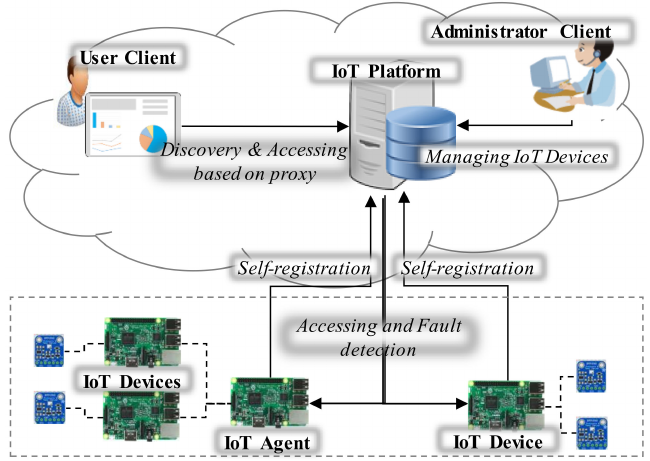
Figure 1. Internet of Things (IoT) architecture for proposed resource